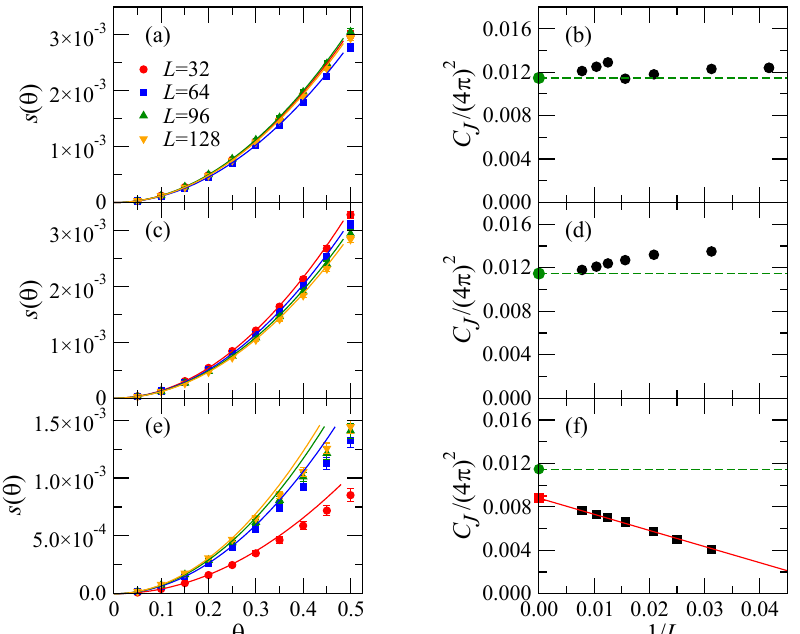
Figure 3: The coefficient of the corner correction s ( θ ) for small values of θ with system size L = 32,64,96,128 at the QCPs for H and H model (e). The lines are the data fitting with s ( θ ) = C J J − Q 3 (f) show the extrapolation of the obtained C In case of (b) and (d), the extrapolated C 0.011 for the O(3) CFT denoted by the green dots and dashe lines. In (f), C for DQC apparently extrapolates to a much smaller number (red square and dashed line) compared with the O(3) value (the green dot and dashed